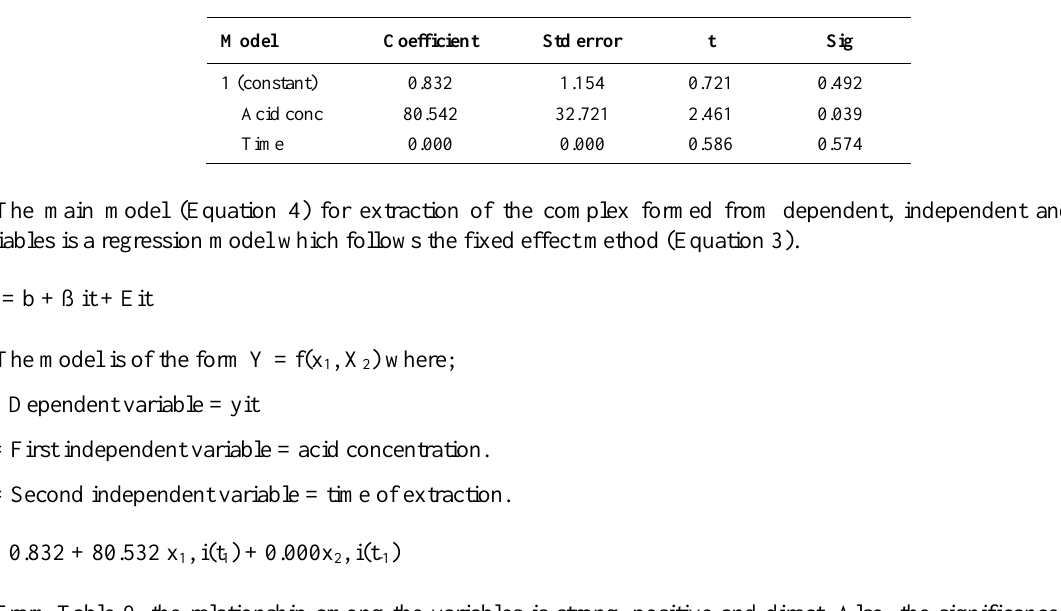
Table 8. The results of regression analysis for the preparation of Fe(III) H 2 SAL complex with metal concentration